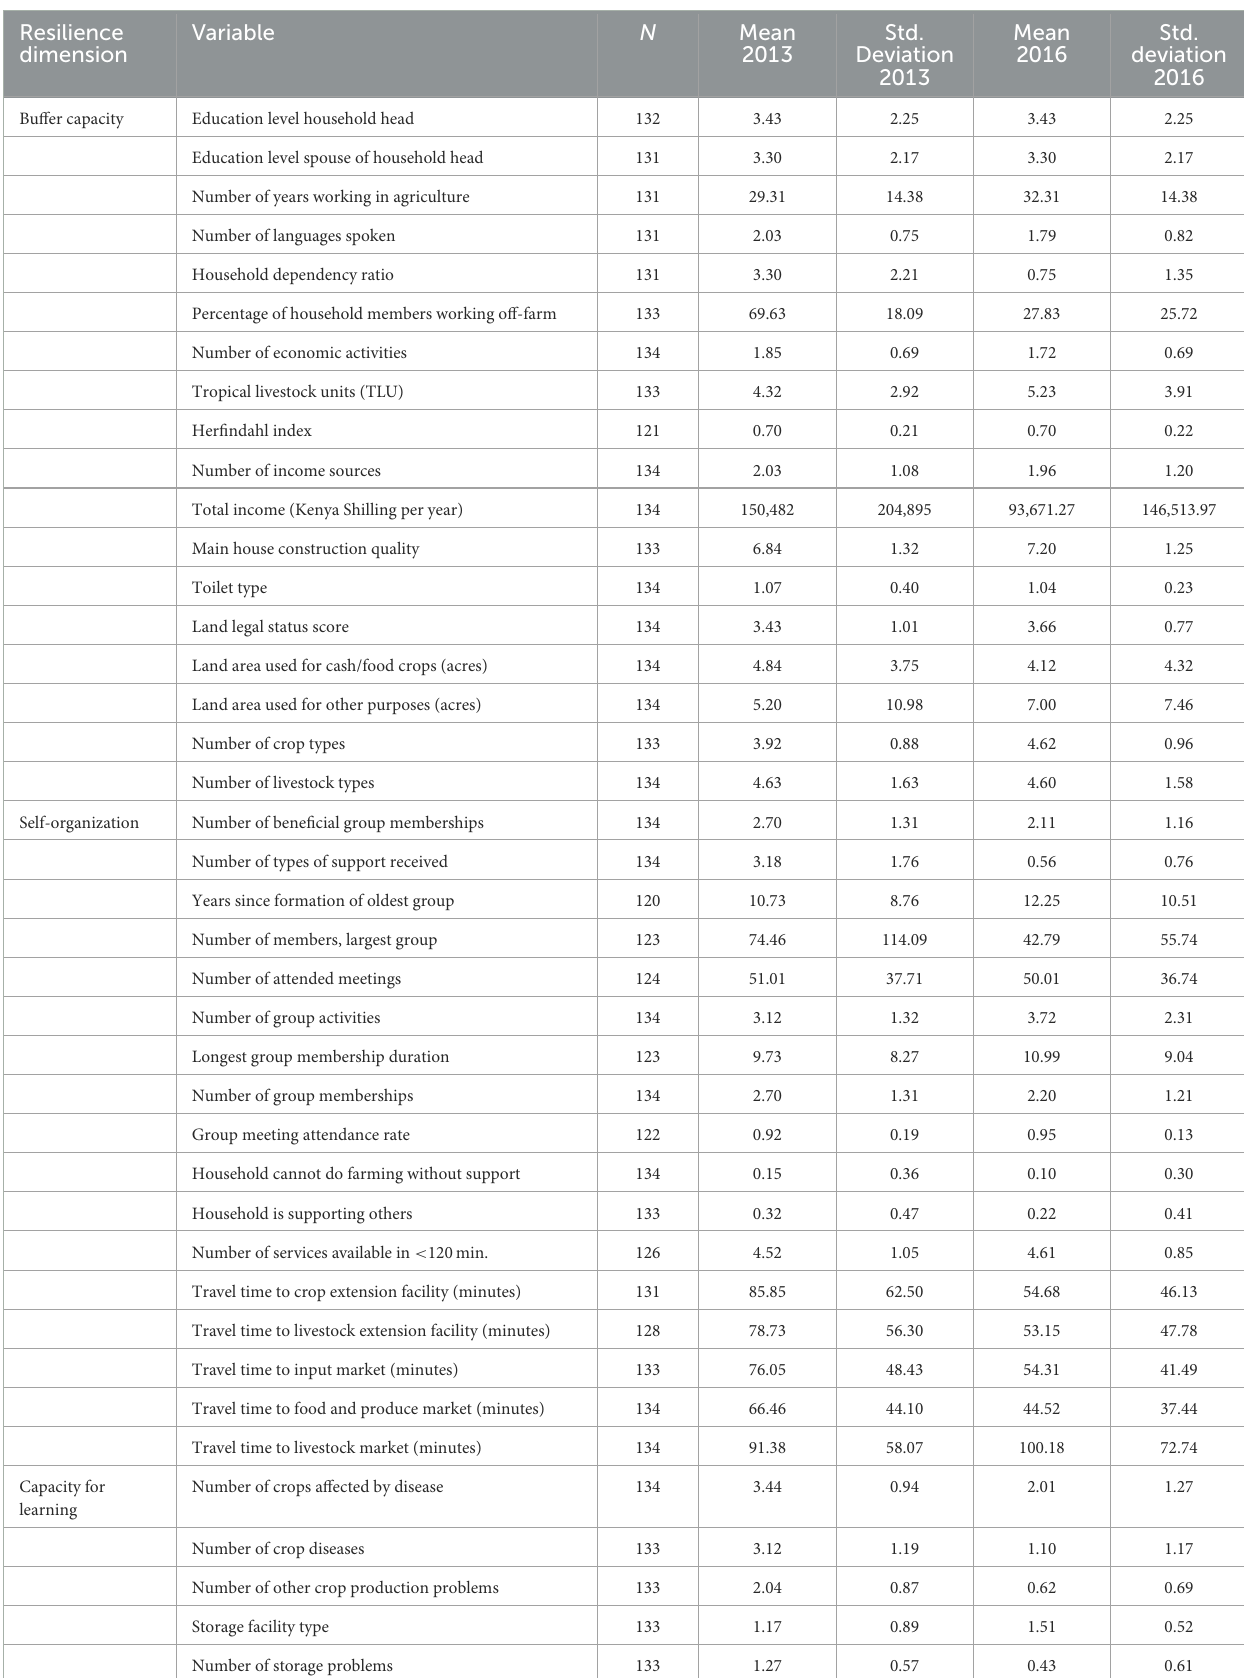
TABLE 1 Main statistics of variables capturing resilience